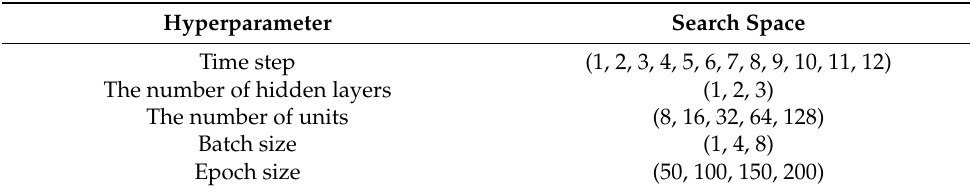
Table 3. Hyperparameters and their specific search space.